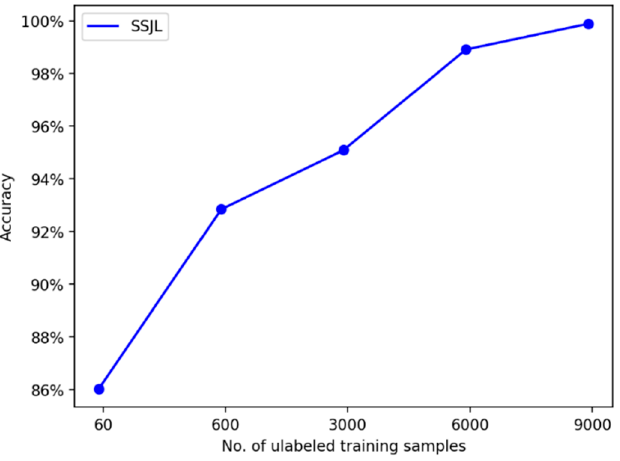
Figure 14. Diagnosis accuracies using different numbers of unlabeled samples on the MFPT dataset.